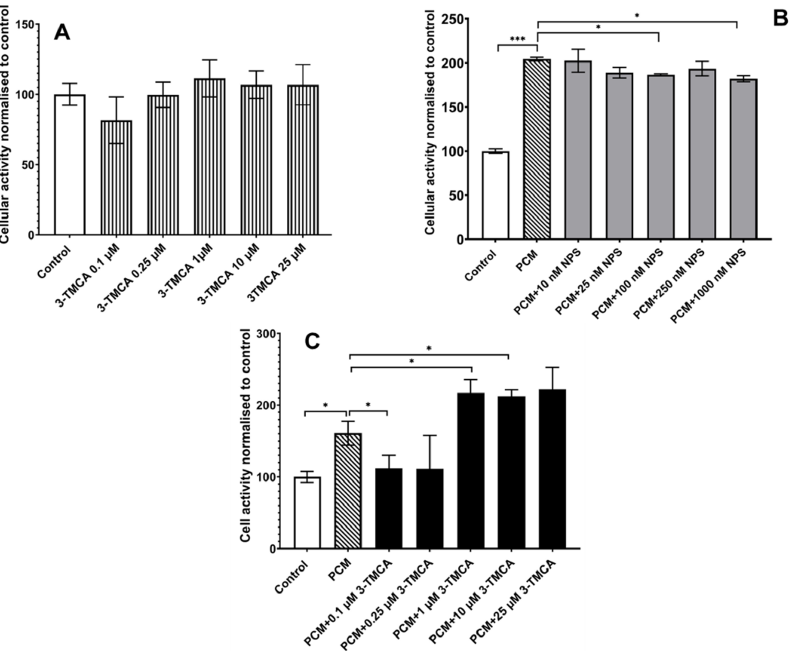
Figure 6. Effect of increasing concentrations of the calcium-sensing receptor agonist 3-TMCA and antagonist NPS 2143 on the cell activity of MG63 cells. Cell activity was assessed using PrestoBlue as described in Section 2. ( A ) Effect of 3-TMCA alone, ( B ) effect of increasing concentrations of NPS 2143 hydrochloride co-incubated with PCM, and ( C ) effect of PCM co-incubated with increasing concentrations of 3-TMCA on the metabolic activity of MG63 cells. Bars indicate the mean cell activity shown as the percentage fluorescence values ( ± SD, n = 3) relative to the control cells incubated in culture medium (CM) only. * = p ≤ 0.05, *** = p ≤ 0.0005.